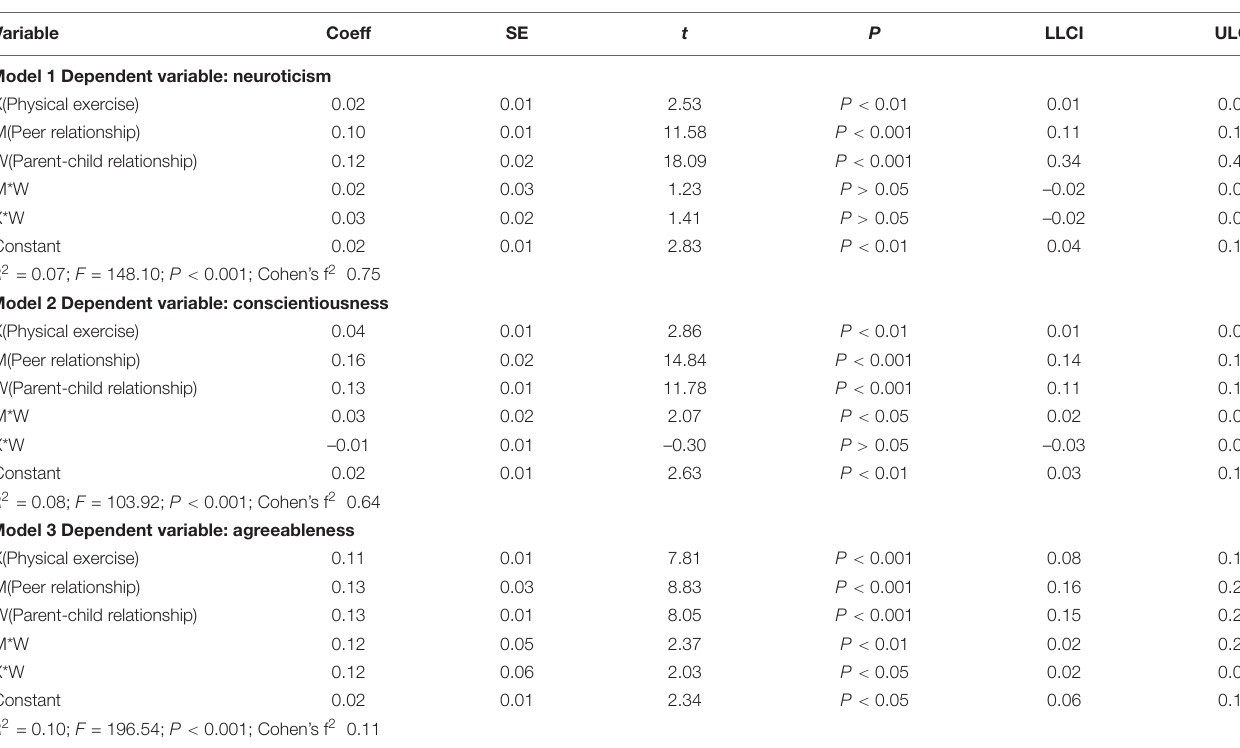
TABLE 4 | Standardized coefficients for the moderated mediation